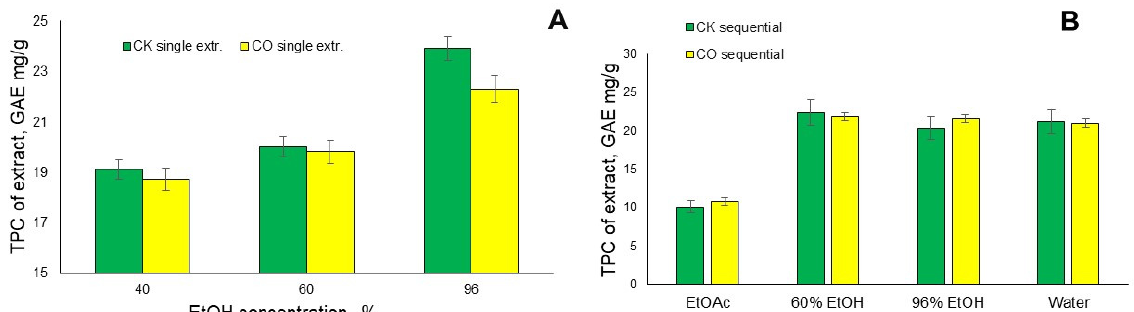
Figure 6. The total phenolic content (TPC) in the extracts isolated from CK and CO spent coffee grounds in the results of it’s ( A ) single step extraction with different ethanol solution concentrations ( B ) sequential extraction with ethyl acetate and 60% and 96% ethanol solution and expressed as GAE mg/g on the isolated extracts ( n = 3, error bars indicate SD).